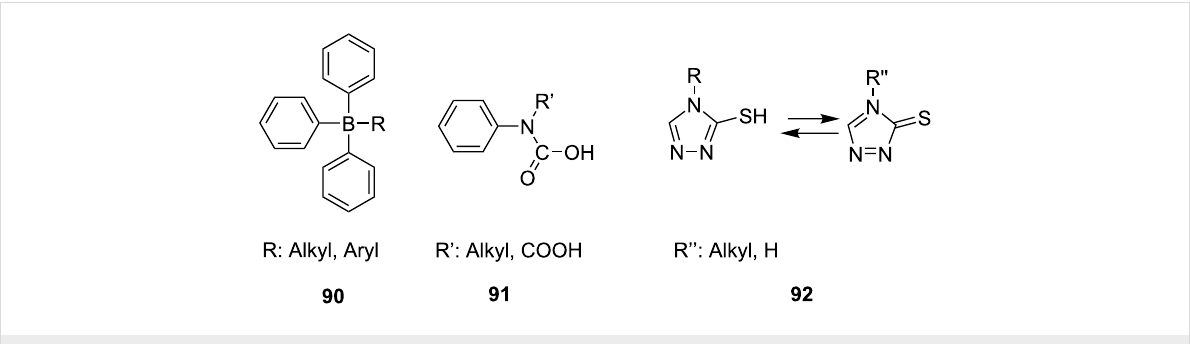
Scheme 8: Structure of donor compounds used in a three component